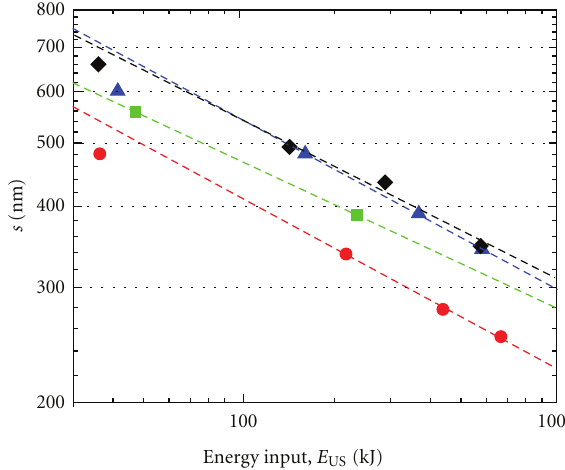
Figure 17: Mean agglomerate size data from fitted log-normal functions as a function of sonication energy input, E US , at di ff erent tip amplitudes: 10% ( (cid:2) ), 20% ( (cid:4) ), 40% ( • ), and bath sonicator ( (cid:3) ). For each tip amplitude, the same datasets as in Figure 16 were used to fit